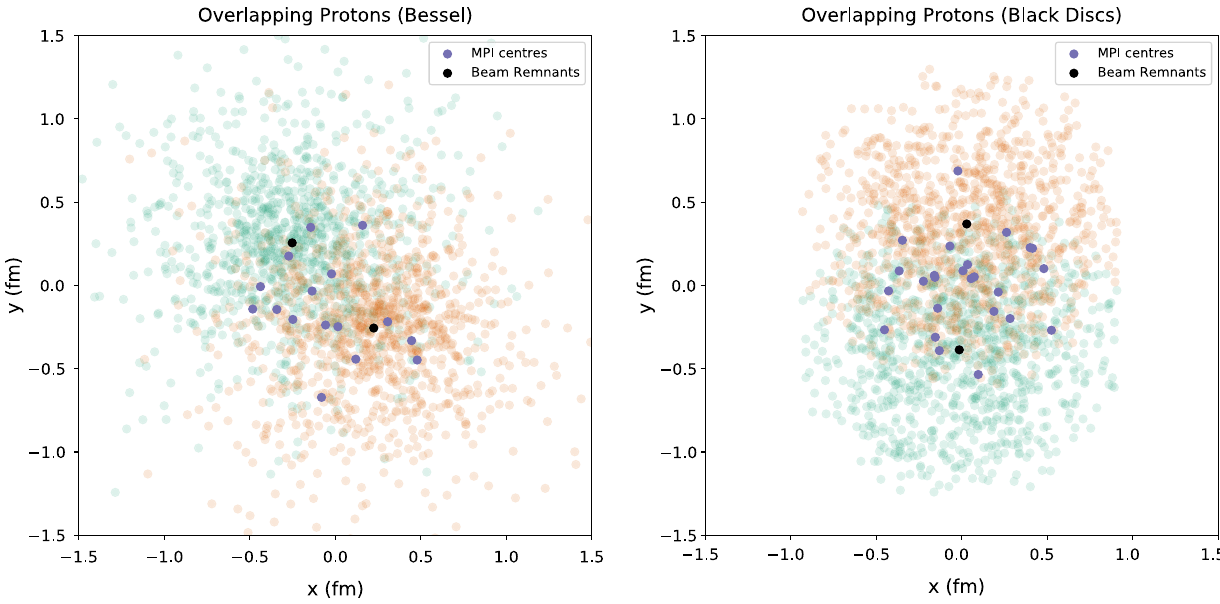
Fig. 2 Result of MPI Coordinate Generator algorithm with the Bessel proton profile (left), and an example for a uniform (black disc) proton profile (right). Green and orange points are partons sampled in a given proton, mauve points are accepted MPI collision centres, and black are the beam